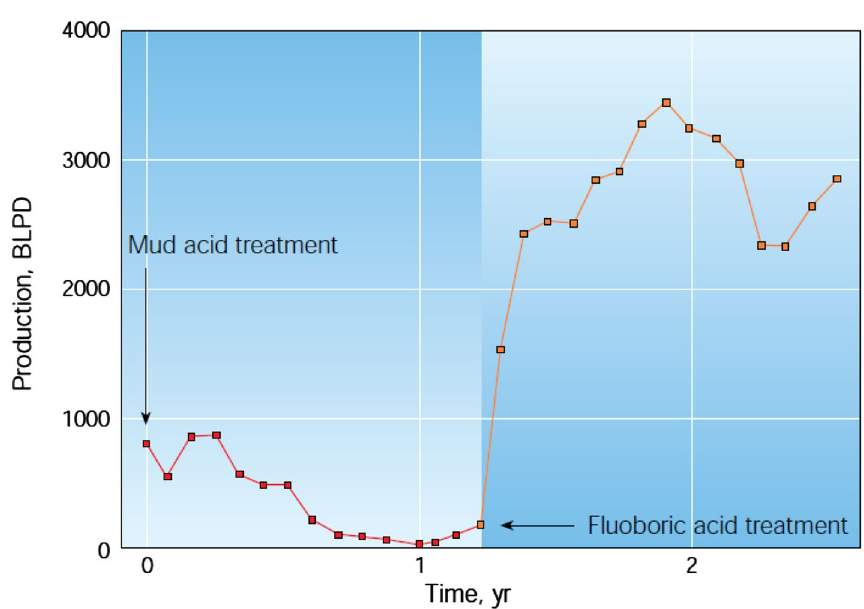
Fig. 8 The production improve- ment in the Nigerian oil well (Ayorinde et al.